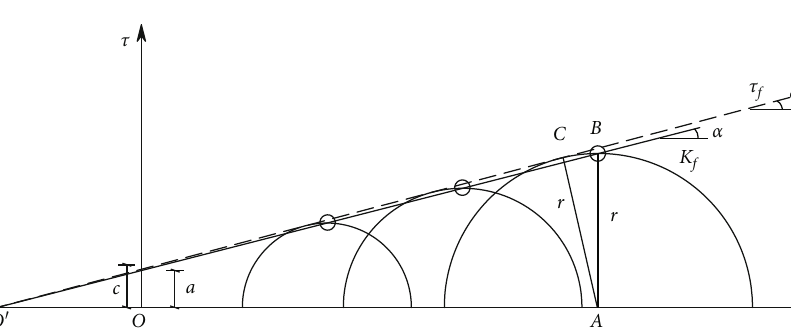
Figure 6: The strength envelope ( τ